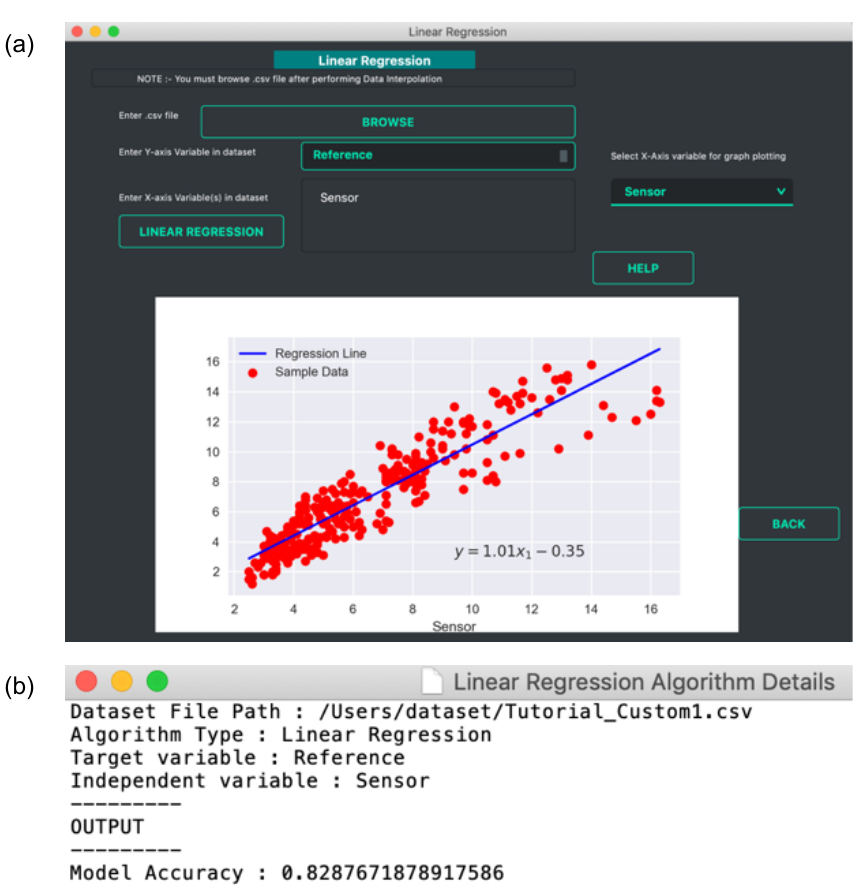
Figure 5. Linear regression example: ( a ) Snapshot of linear regression GUI with regression plot and ( b ) snapshot of the text file showing regression model